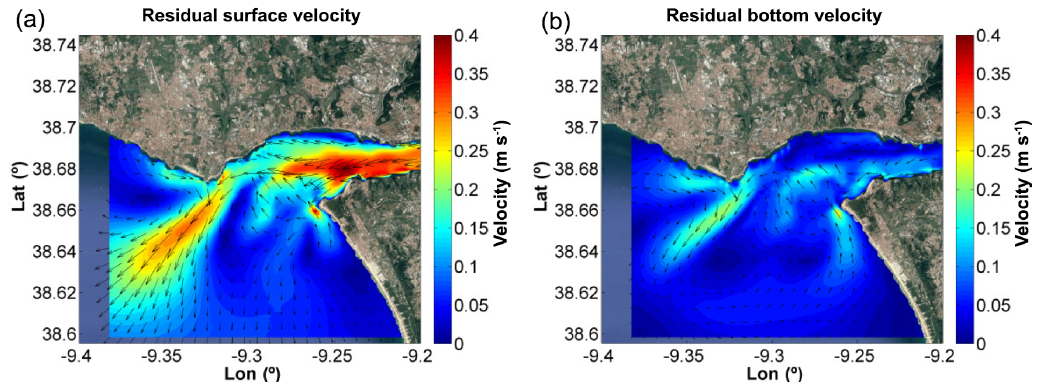
Figure 10. Residual velocity in the Tagus Estuary mouth at the surface (a) and near the bottom (b) obtained from the 3-D baroclinic model for the Tagus Estuary.